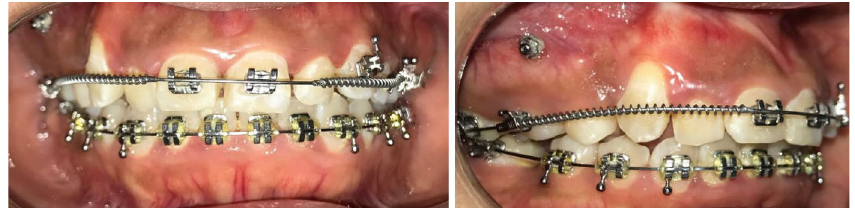
Figure 4: Three months of active space opening and spontaneously letting the canine root move into the alveolar bone.